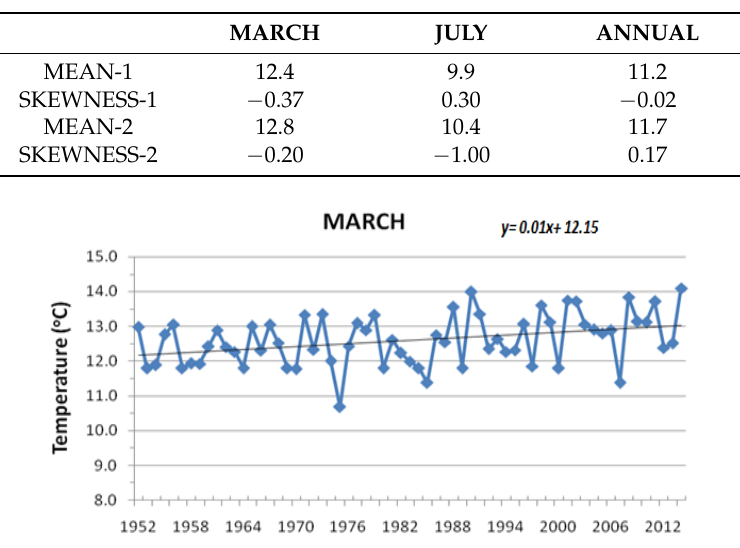
Figure 5. The time series of the March minimum temperature.